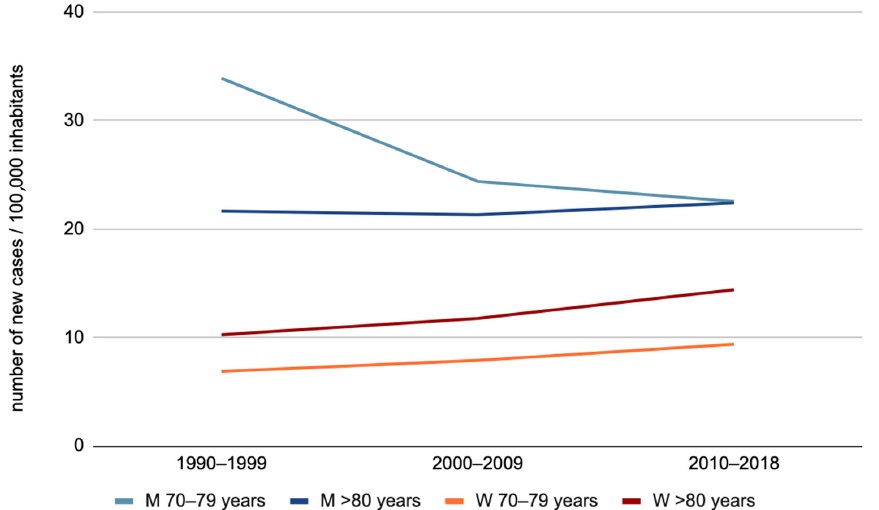
Figure 2. Evolution of oral cavity cancer incidence by sex for the “70–79 years” and “80 years or more” age groups (M: men, W: women).